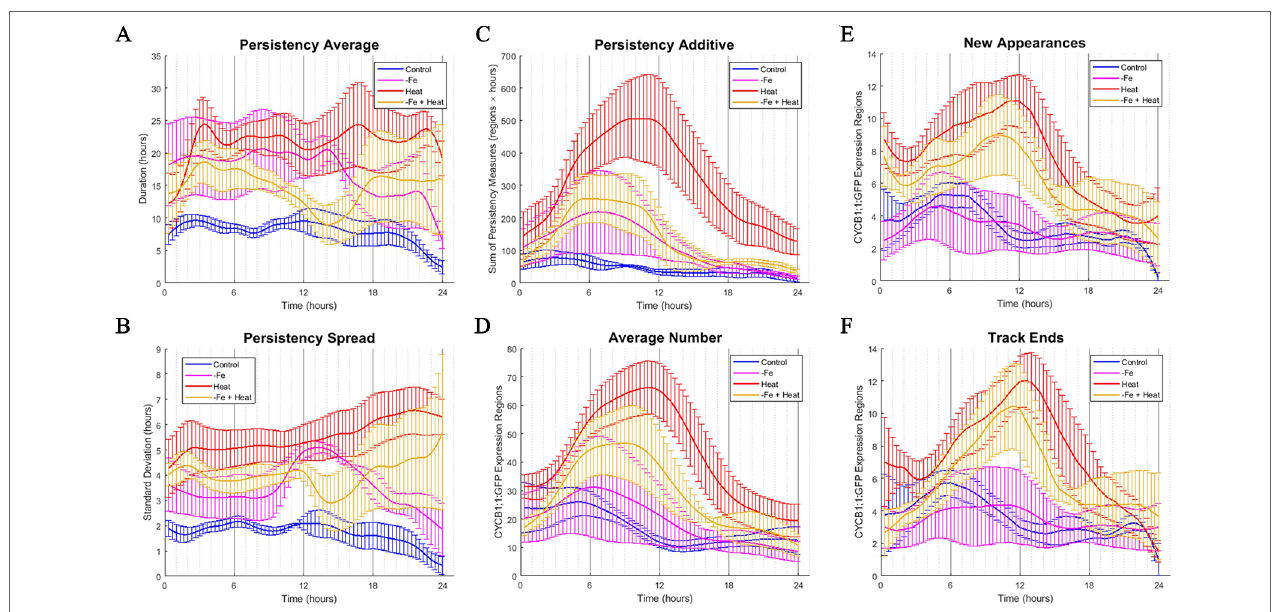
FIgURE 4 | Time-course profiles of individual metrics obtained from the image analysis software. (A – F) Metrics obtained from image analysis of all conditions over a 24-h time period. Error bars indicate standard error from the biological replicates (n = 3 to 4). (A) PERSISTENCY AVERAGE metric showing the average time (in hours) that ROIs were tracked. This corresponds to how long cells were expressing CYCB1;1:GFP. (B) PERSISTENCY SPREAD metric showing the standard deviation of ROI persistency measures. This corresponds to the variety of lengths of time that cells expressed CYCB1;1:GFP. (C) PERSISTENT ADDITIVE metric showing the cumulative sum of persistency measures from detected ROIs at any one time. (D) AVERAGE NUMBER metric showing the average number of ROIs detected by the software at any one time. An increase in AVERAGE NUMBER corresponds to an increased number of cells producing CYCB1;1:GFP (E) NEW APPEARANCES metric showing the average number of newly appearing ROIs at any one time. This corresponds to the average number of new cells expressing CYCB1;1:GFP (F) TRACK END metric showing the average number of ROIs ceasing to be tracked by the software at any one time.